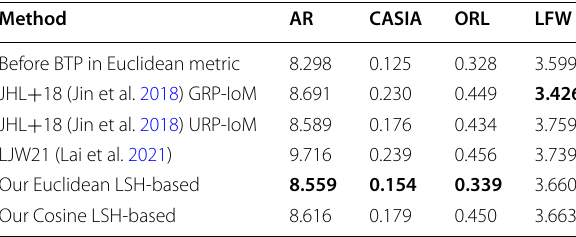
The lowest value of EERs of different schemes are marked in